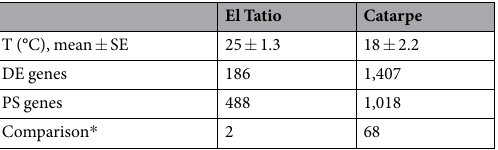
Table 1. Summary of the results of the screening performed to find candidate genes for local adaptation to temperature in larvae of Rhinella spinulosa from El Tatio and Catarpe (Chile). DE, differentially expressed; PS, positive selection. * Intersection between DE genes and PS